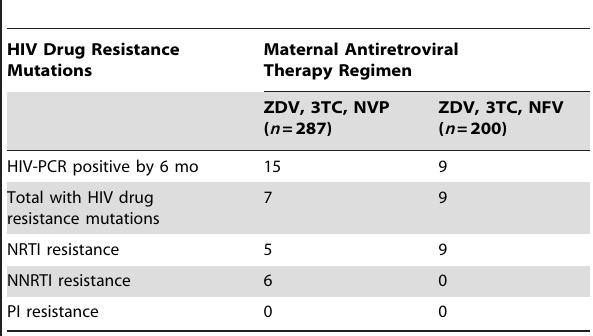
Table 2. HIV drug resistance mutations among breastfeeding infants at 6 mo post partum according to maternal regimen.